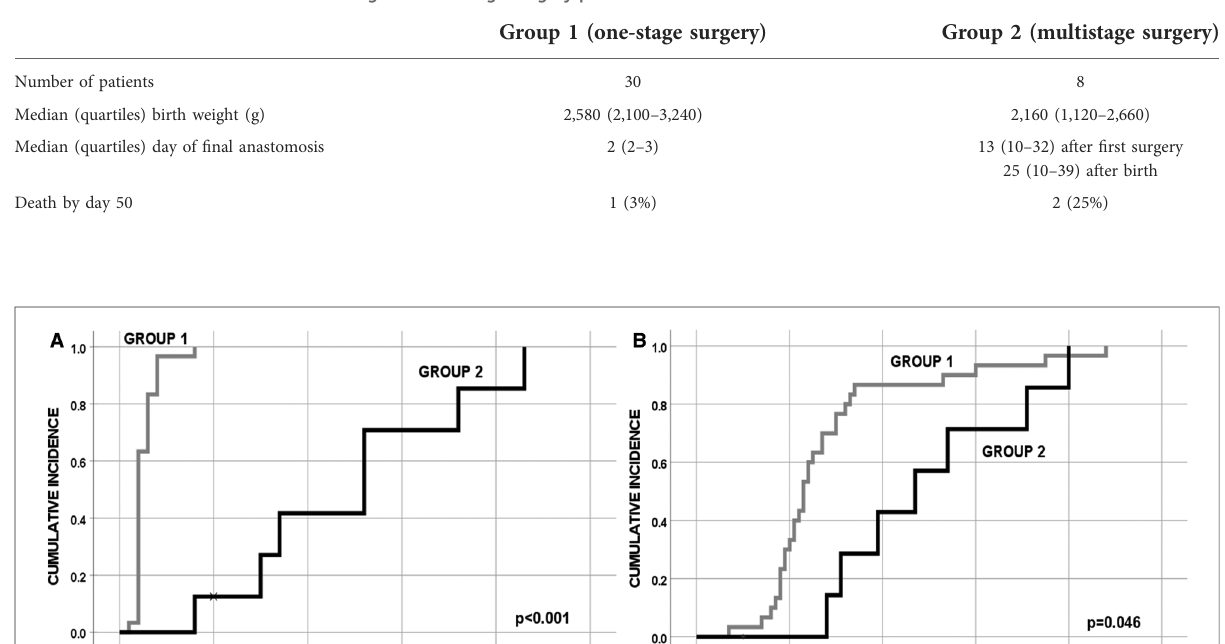
TABLE 5 Clinical characteristics of one-stage vs. multistage surgery patients.